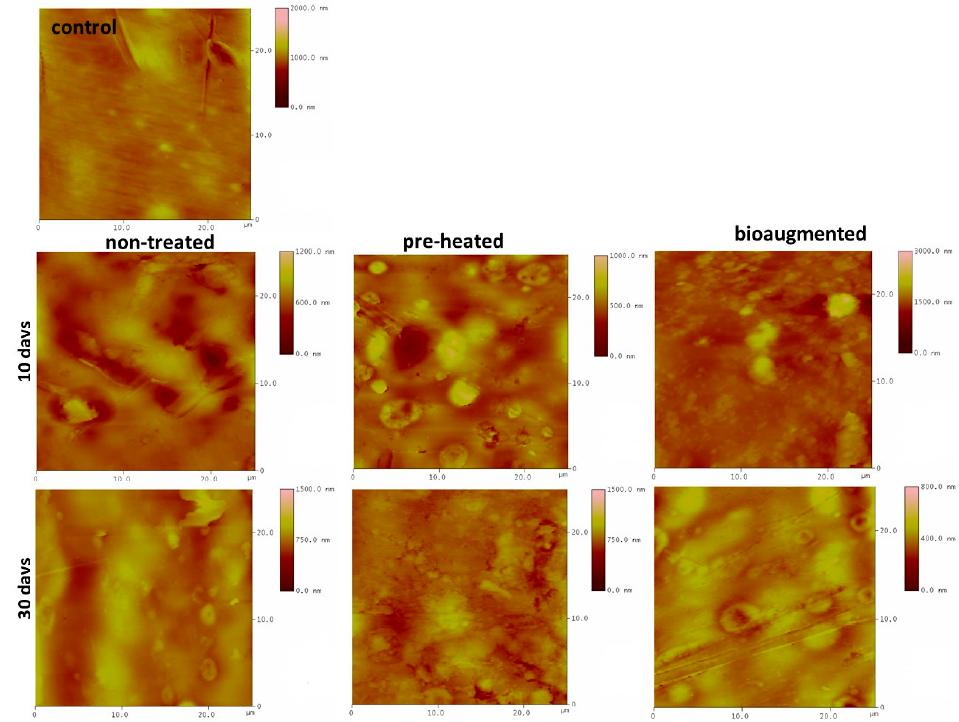
Figure 7. 2D AFM images, (25 × 25) μ m, of PVA/TPS films before degradation (control) and after 3, 10, and 30 days of degradation under different model composting conditions.